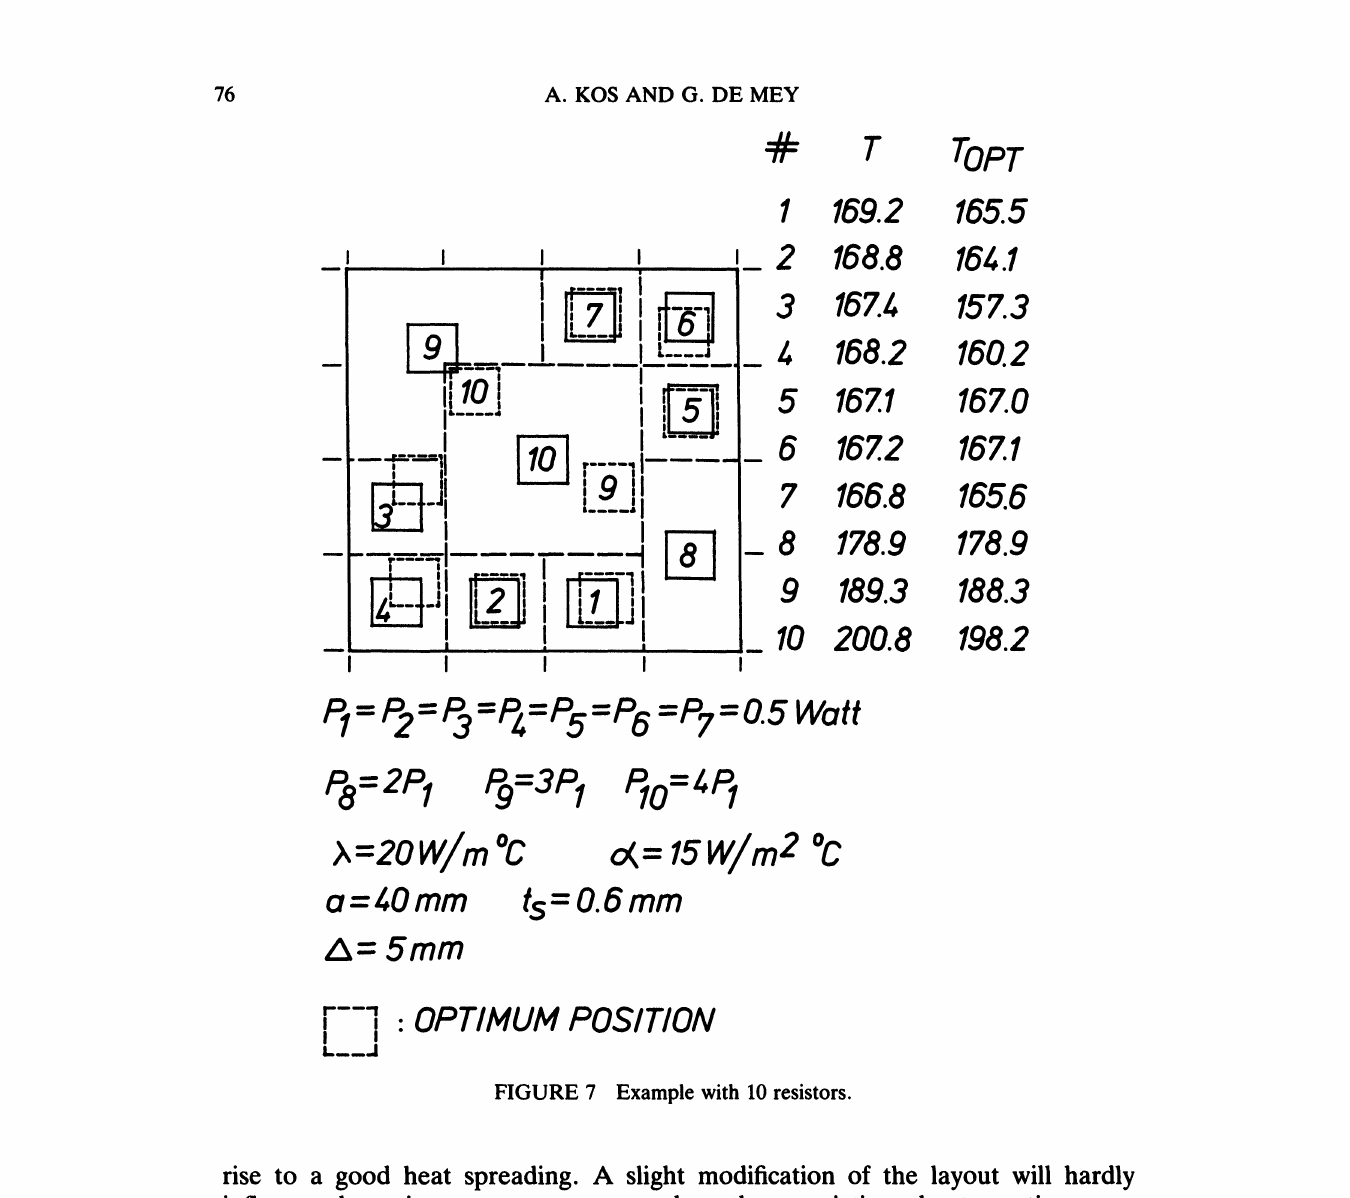
FIGURE 7 Example with 10